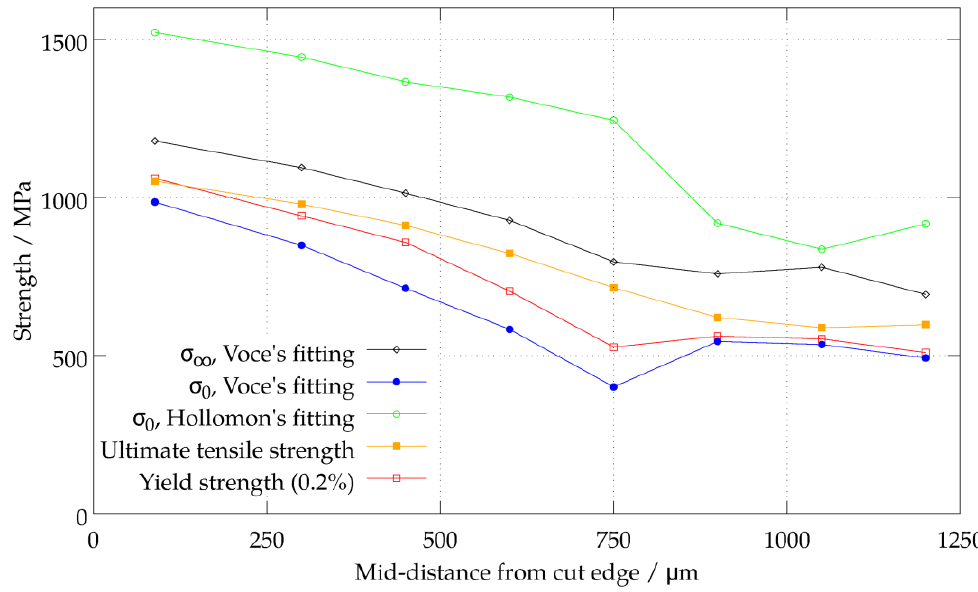
Figure 9. Evolution of mechanical properties as a function of distance to cut edge.